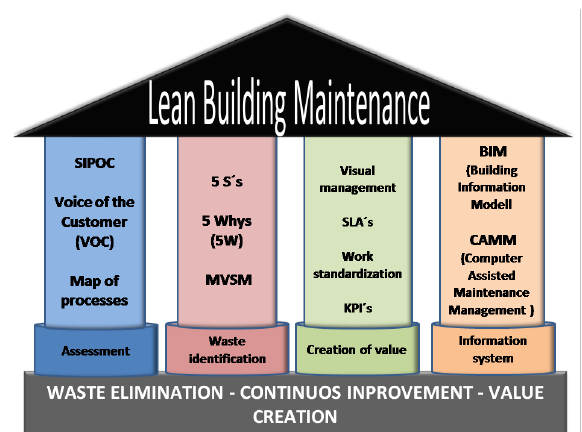
Figure 2: The house of